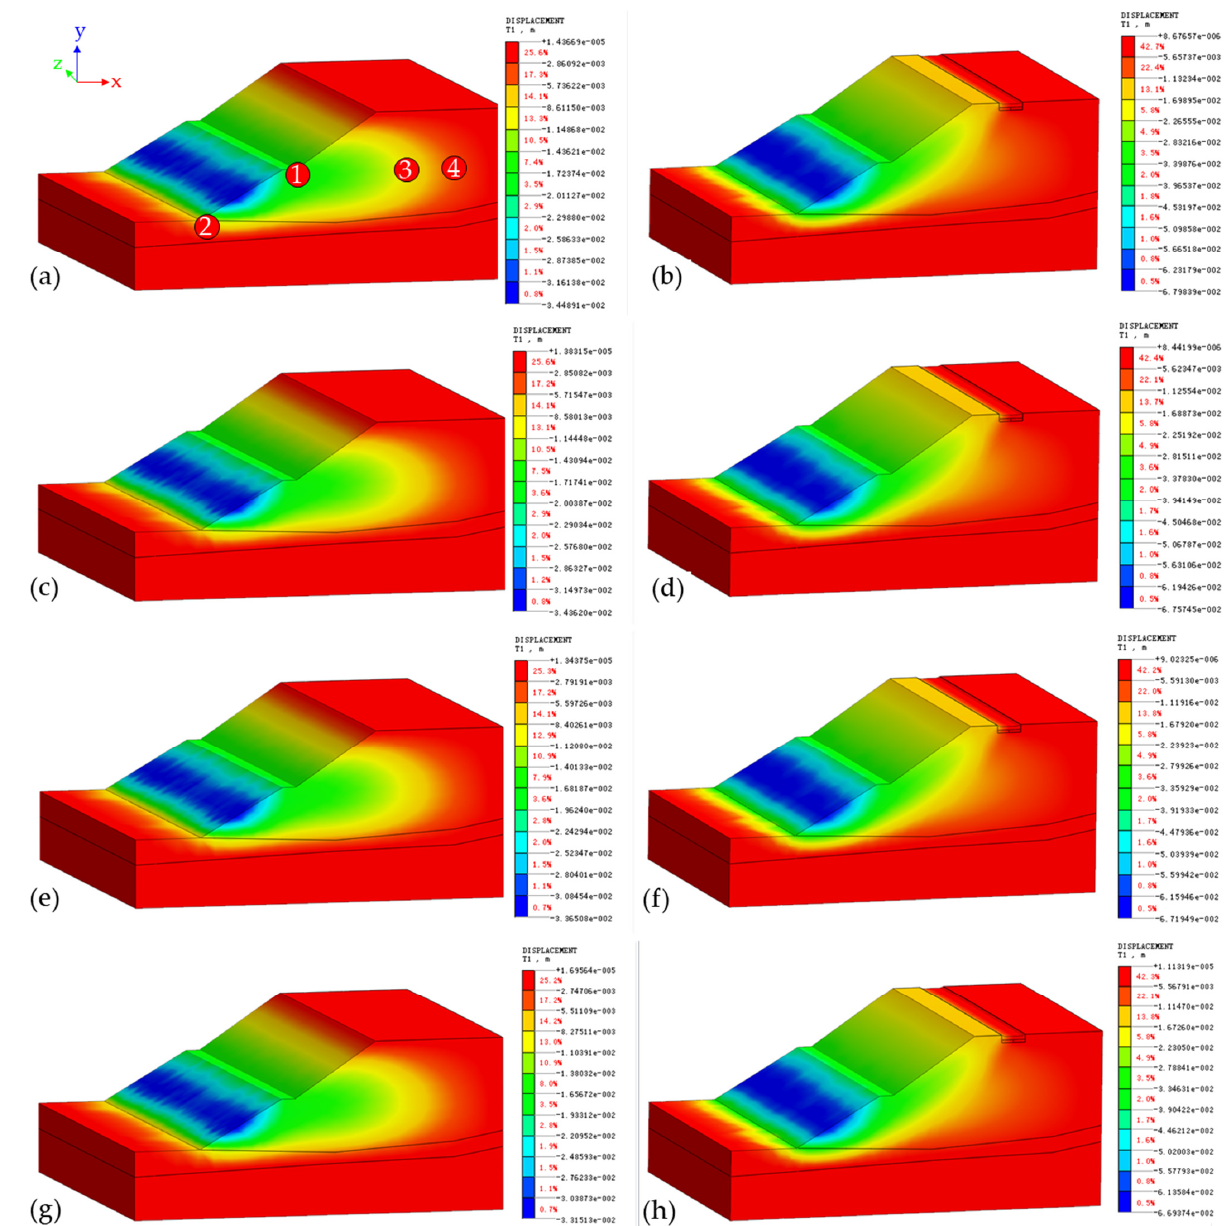
Figure 9. Comparison of horizontal displacement distribution in subgrade slopes without or with biological retention facilities within 48 h after rainfall: ( a , b ) 6 h; ( c , d ) 12 h; ( e , f ) 24 h; ( g , h ) 48 h.